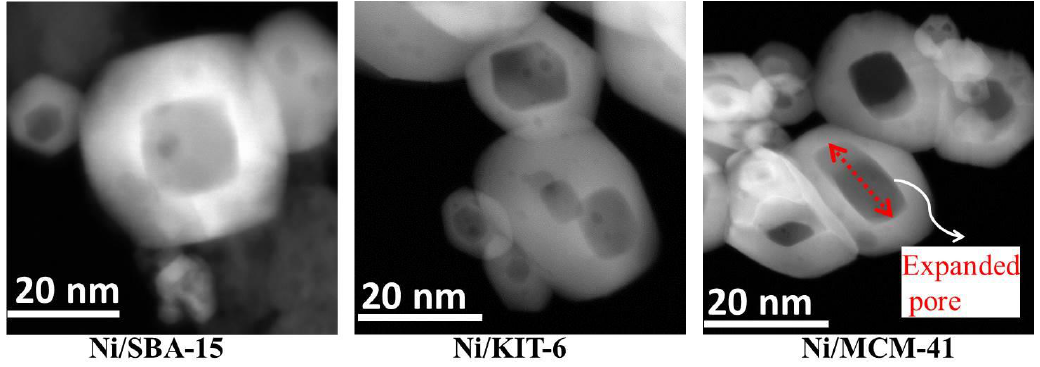
Figure 11. HAADF-STEM images of Ni particles inside the pores of SBA-15, KIT-6 and MCM-41.